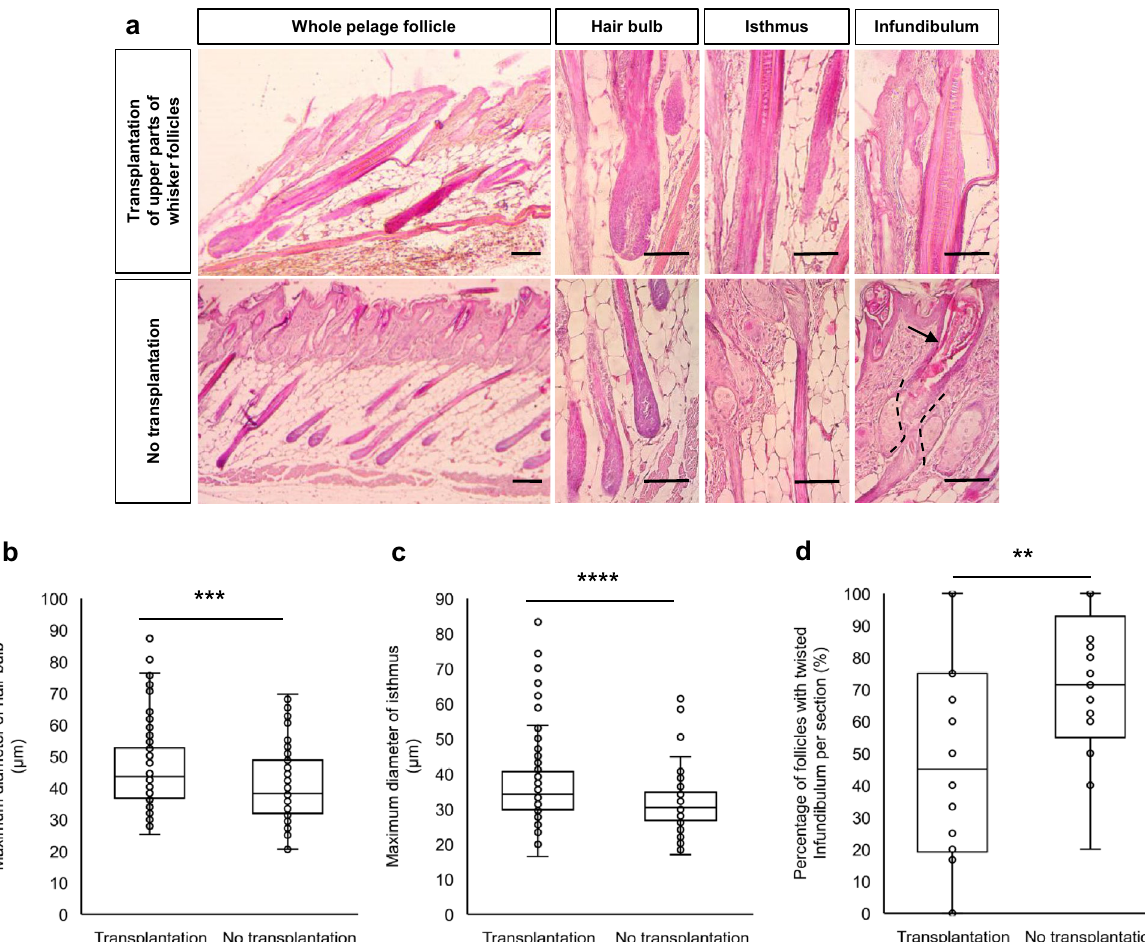
Figure 3. Morphological change of pelage follicle of nude mice after transplantation of upper parts of whisker follicle from ND-GFP mice. ( a ) Hair bulb, isthmus and infundibulum of pelage follicles in nude mice after transplantation of upper part of whisker follicles from ND-GFP mice. Black dotted lines indicate the twisted part of the infundibulum. Black arrows indicates amorphous eosinophilic material within the infundibulum. Scale bar = 50 µm. ( b ) The diameter of hair bulb of nude-mouse pelage follicle 7 days after transplantation of the upper part of whisker follicles from ND-GFP mice, or without transplantation (mean ± SEM = 46.30 ± 1.24 (transplantation), 40.71 ± 0.91 (no transplantation); n = 109 hair follicles, 5 mice transplanted with the upper part of whisker follicles from ND-GFP mice; n = 149 hair follicles, 5 non-transplanted control mice). ( c ) The diameter of isthmus of nude-mouse pelage follicle 7 days after transplantation of the upper part of whisker follicles from ND-GFP mice or without transplantation (mean ± SEM = 36.62 ± 0.87 (transplantation), 31.22 ± 0.77 (no transplantation); n = 140 hair follicles, 5 mice transplanted with upper parts of whisker follicles from ND-GFP mice; n = 101 hair follicles, 3 non-transplanted control mice). ( d ) The percentage of twisted infundibula 7 days after transplantation of upper parts of whisker follicles from ND-GFP mice or without transplantation in nude mice (mean ± SEM = 46.95 ± 6.23 (transplantation), 71.77 ± 4.07 (no transplantation); 153 hair follicles, 5 mice transplanted with the upper part of whisker follicles from ND-GFP mice; 146 hair follicles, 3 non-transplanted control mice). Data are presented as box and whisker plots in ( b ), ( c ), ( d ). Population medians, first and third quartiles are represented by the boxes, maxima and minima by the whiskers, and individual numerical value by the overlaid single points, respectively. Two-sided unpaired Student’s t- test was applied for all statistical analyses in this figure. Significance was indicated as ** P < 0.01, ***P < 0.001, ****P < 0.0001. Source data are provided as a Source Data